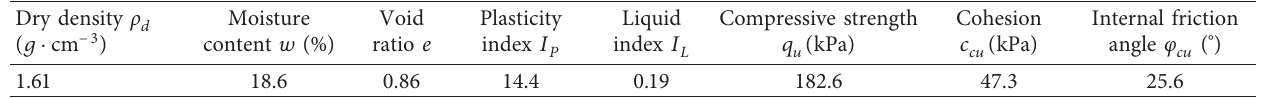
Table 1: Physical and mechanical parameters of loess in the tunnel site.